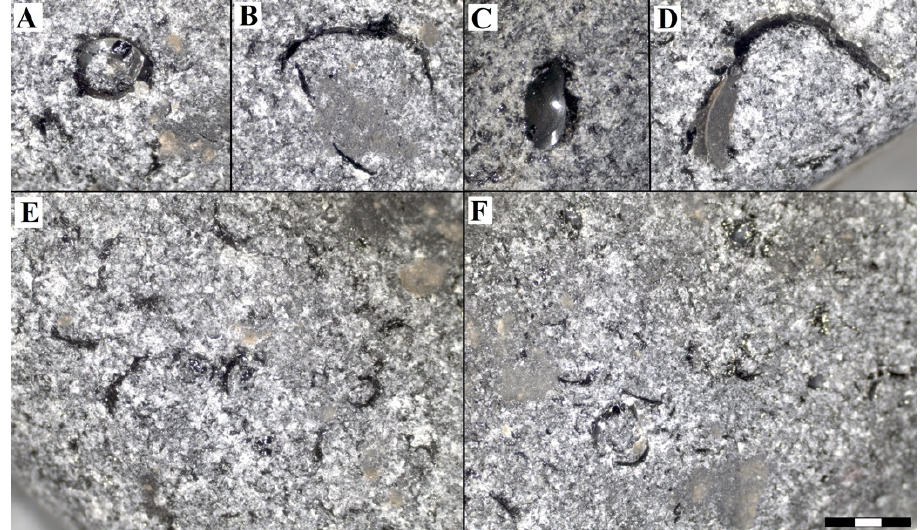
Figure 7. Different types of percussion marks generated in the experiment for the rounded samples: ( A ) circular, ( B ) crescent, ( C ) pseudo-circular, ( D – F ) crescent. The bottom right bar measures a total of 3 mm, the same from ( A – F ).